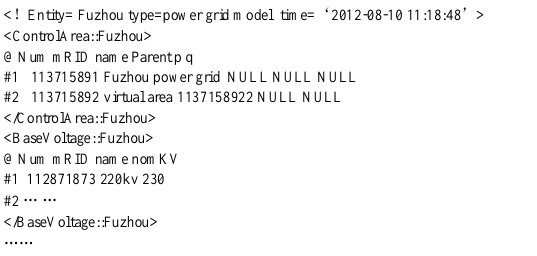
Fig. 10 Format of model data.